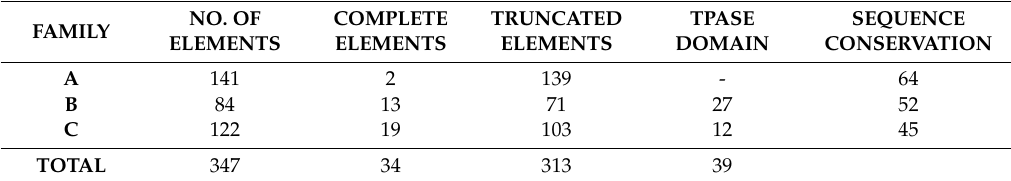
Table 1. Description of the three CACTA families identified in the sunflower